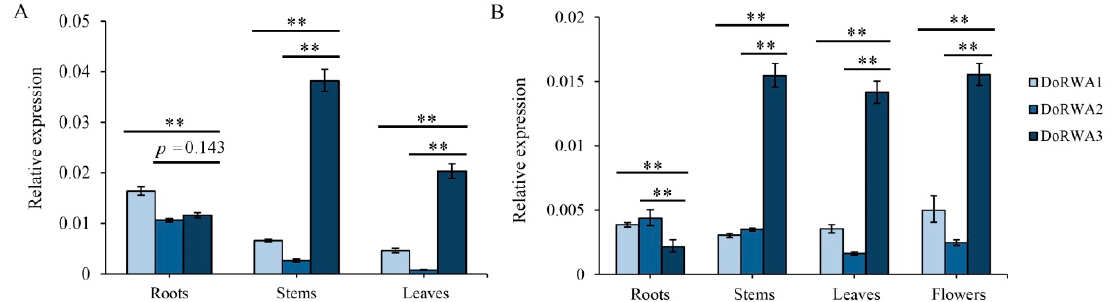
Figure 6. Expression profiles of DoRWA genes in different organs. Relative expression levels of three DoRWA genes in different organs of ( A ) seedlings and ( B ) adult plants. In A and B, EF-1 α served as the control. Each data bar represents the mean ± SD ( n = 3). ** indicates p < 0.01 between the expression level of DoRWA3 and DoRWA1 ( DoRWA2 ) according to DMRT.